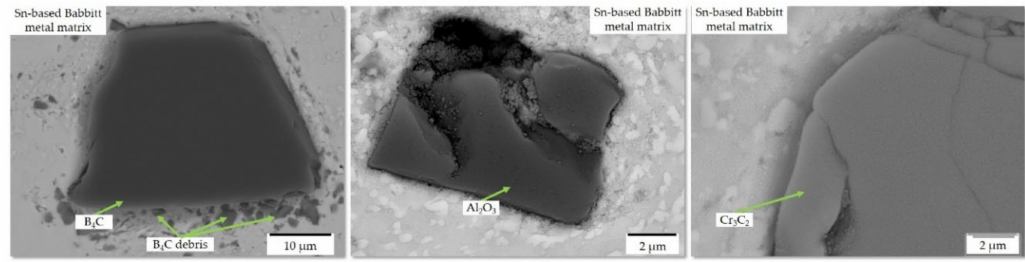
Figure 8. Embedding of hard particles in Sn-based Babbitt coating.